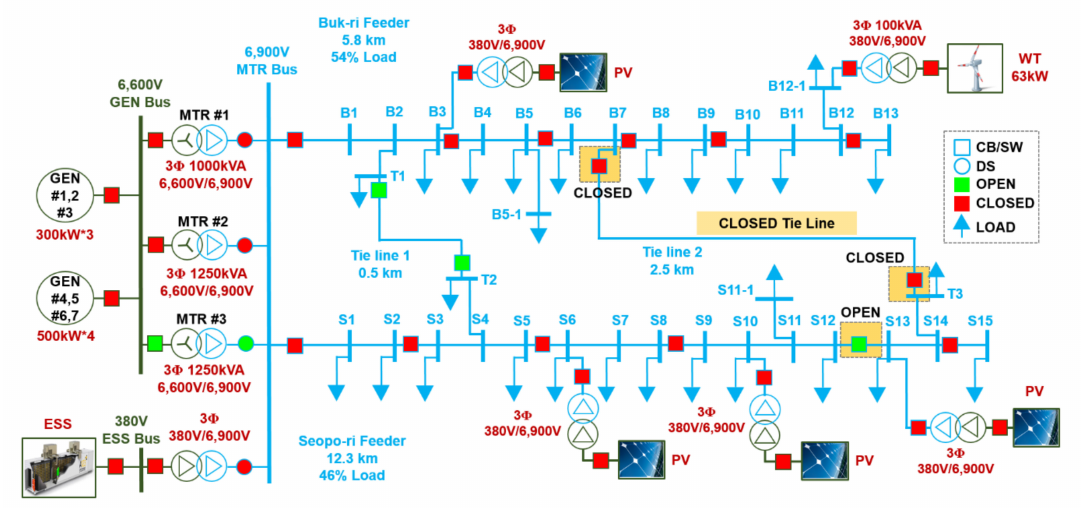
Figure 18. Power system reconfiguration for Deokjeok Island